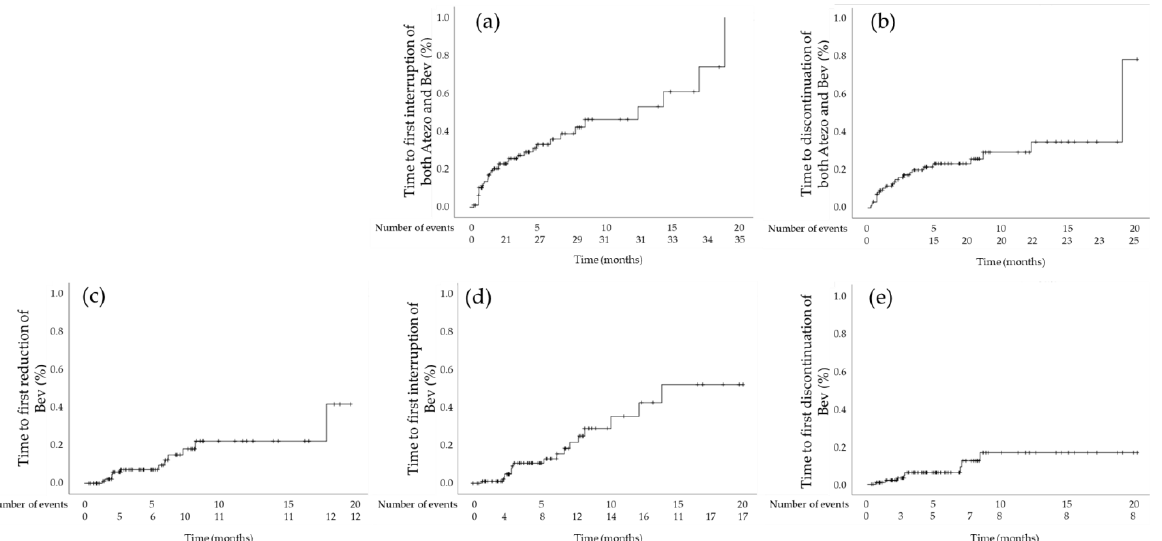
Figure 4. Kaplan – Meier estimates of cumulative ( a ) time to first interruption of both Atezo and Bev; ( b ) time to discontinuation of both Atezo and Bev; ( c ) time to first reduction in Bev dose; ( d ) time to first interruption of Bev; and ( e ) time to discontinuation of Bev. Abbreviations: Atezo, atezolizumab; Bev, bevacizumab.